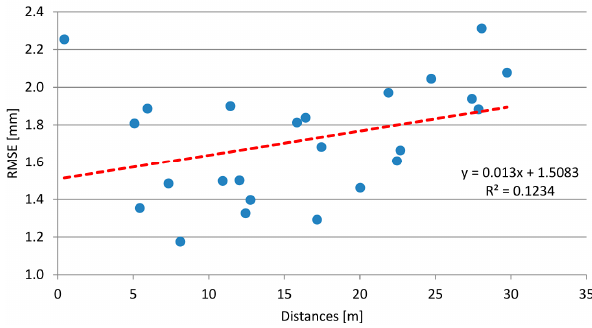
Figure 6. Error in the estimation of the plane that fits the points belonging to each slab, depending on the distance between the centroid and the TLS station. Table 3. Values of the angle ϑ between the local orthogonal lines and the perpendicular to the general plane together with the associated SD.